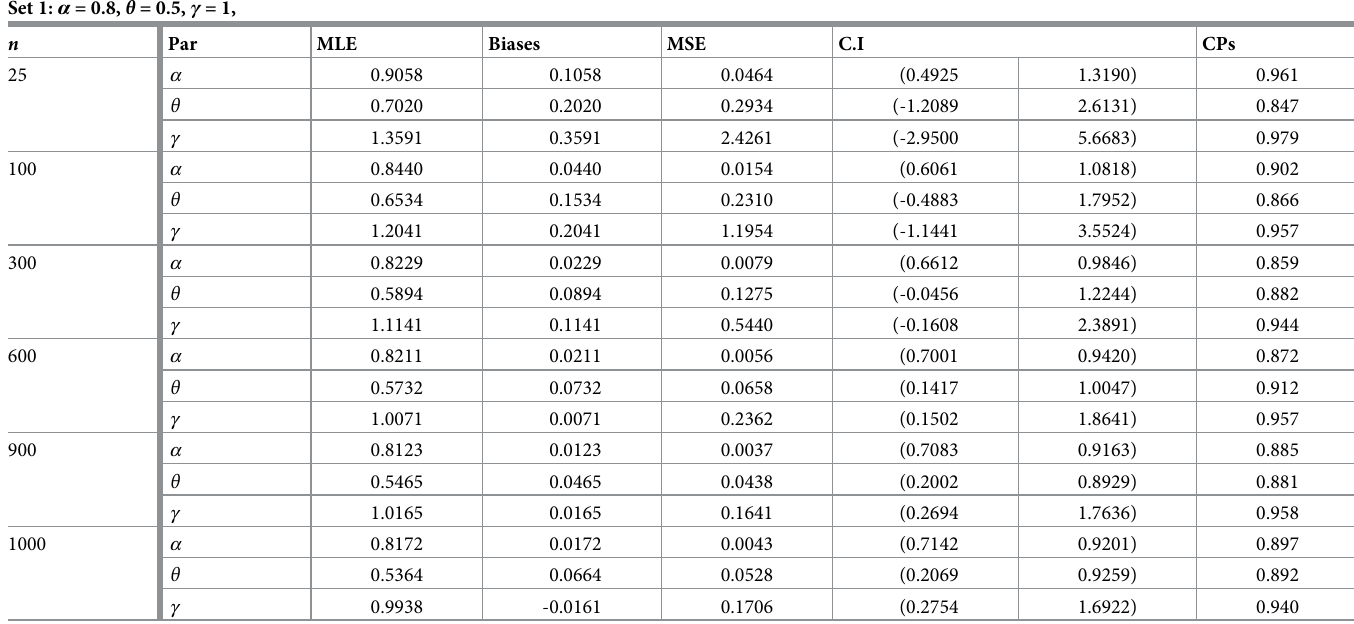
Table 3. Simulation results for different combination of the parameters of TI-HTW distribution.